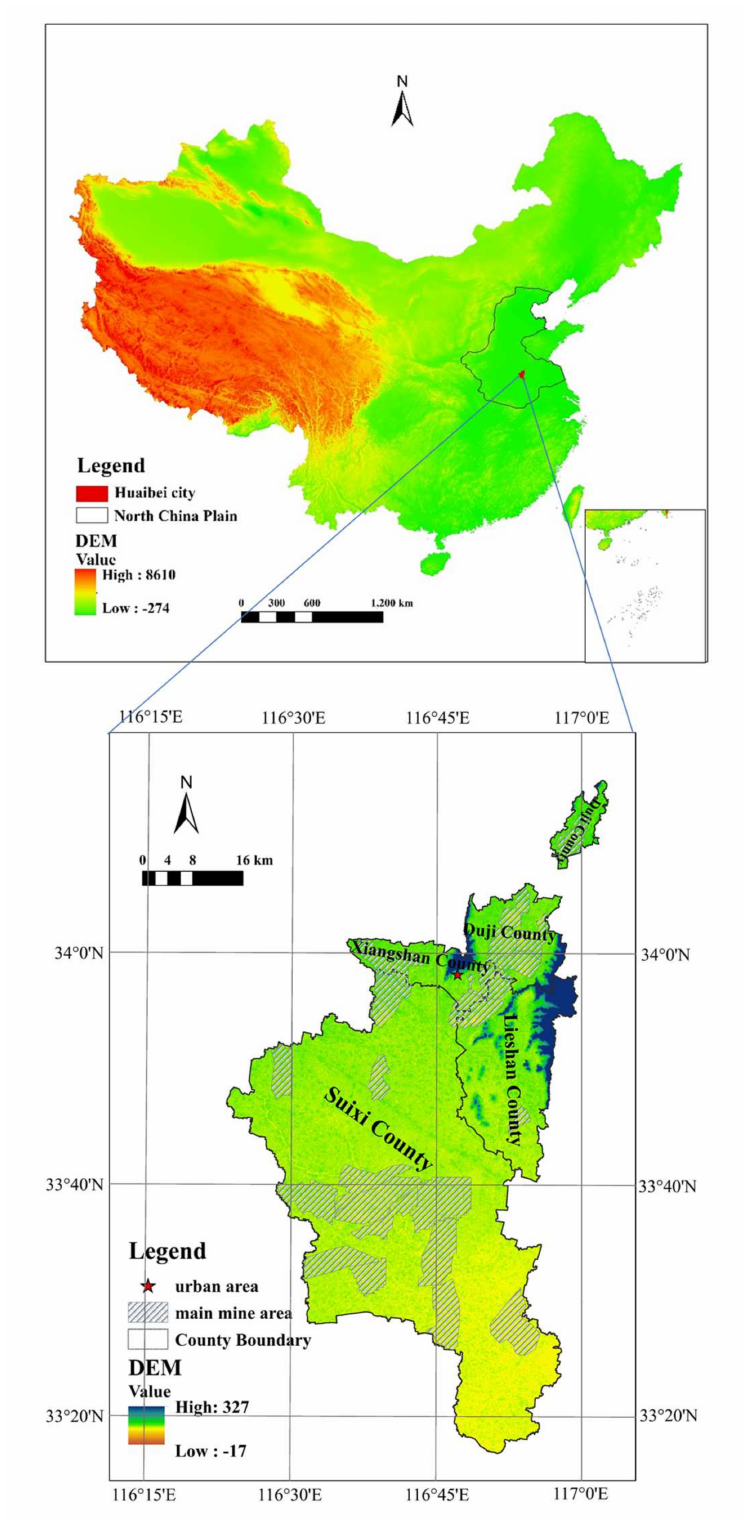
Figure 1. Huaibei’s geographical location in China (note: the figure is drawn by the